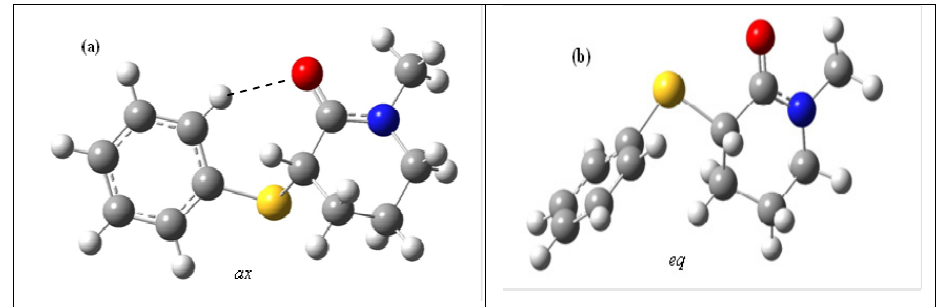
Figure 2. Axial ( ax ) ( a ) and equatorial ( eq ) ( b ) conformers for 4 obtained at the B3LYP/ 6-31+G(d,p) level.